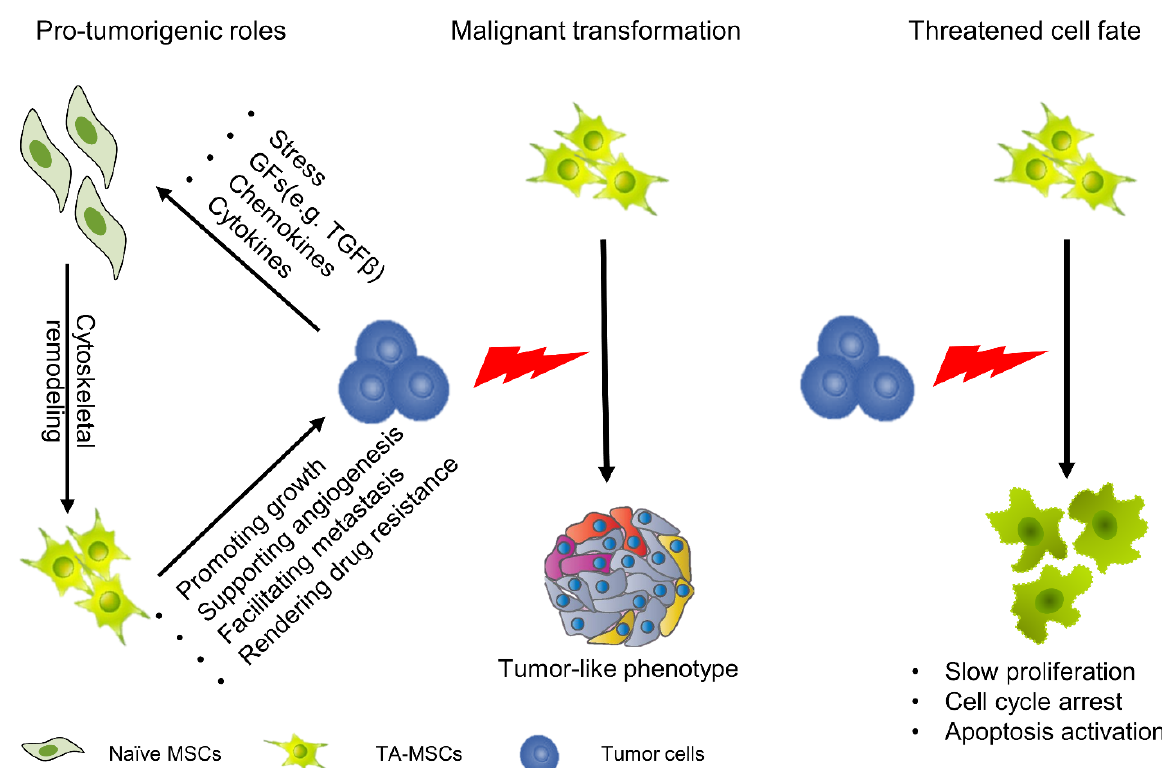
Figure 1. Cellular function and fate of MSCs in the TME. MSCs can migrate to tumors, and under the education of tumor cells, evolve into TA-MSCs. In this process, the function and fate of MSCs undergo profound changes. TA-MSCs play an important role in promoting tumor growth, supporting tumor angiogenesis, facilitating tumor metastasis and rendering tumor drug resistance. Meanwhile, some studies have found that TA-MSCs undergo malignant transformation. On the other hand, some studies have demonstrated that TA-MSCs show significant reductions in cell viability with cell cycle arrest.